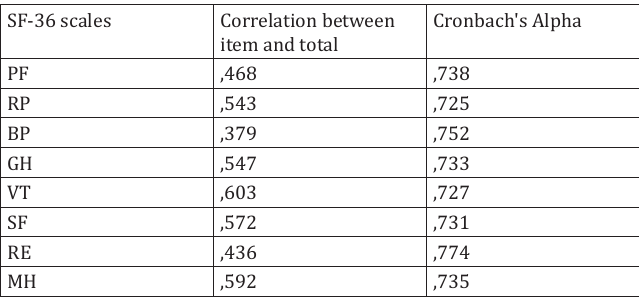
Reliability of the SF-36